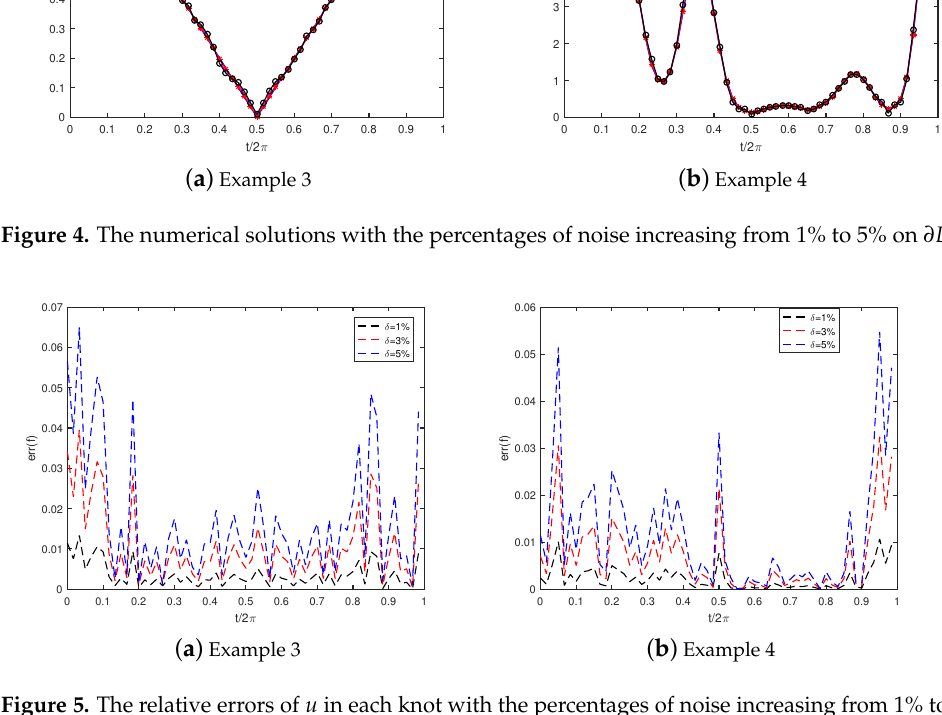
Figure 5. The relative errors of u in each knot with the percentages of noise increasing from 1% to 5% on ∂ D